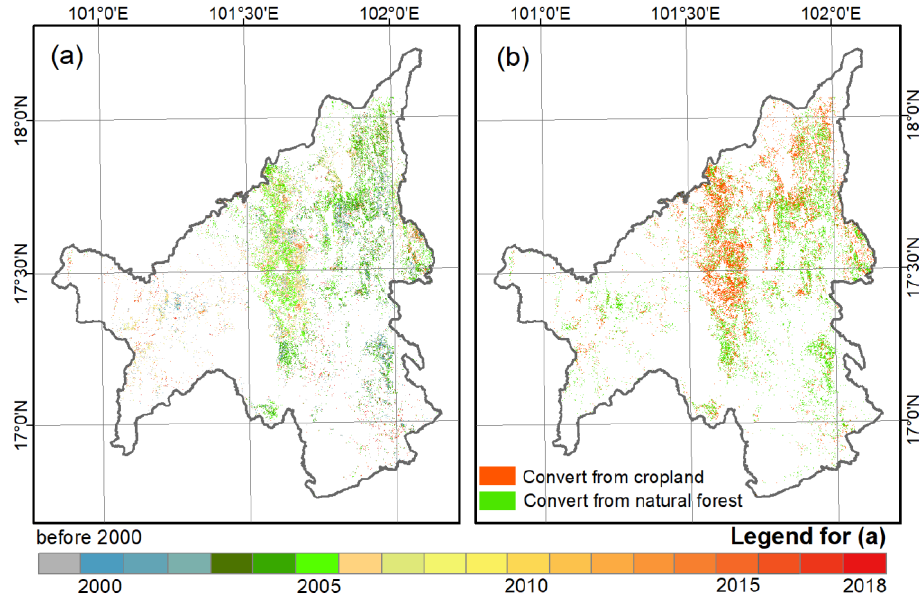
Figure 6. ( a ) Planting year estimation, and ( b ) pre-conversion land-cover types of cropland and natural forest in Loei Province.